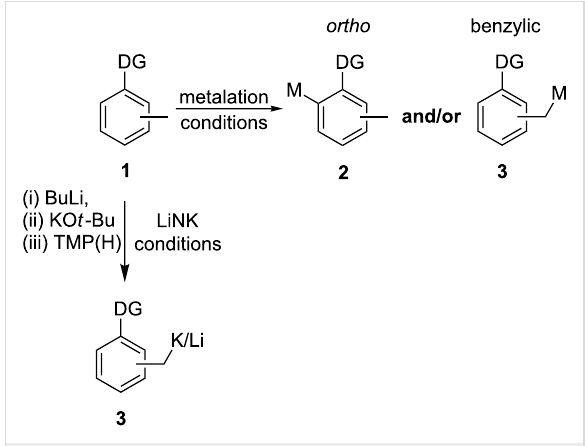
Scheme 1: Selective benzylic metalation with LiNK conditions. DG = directing group.